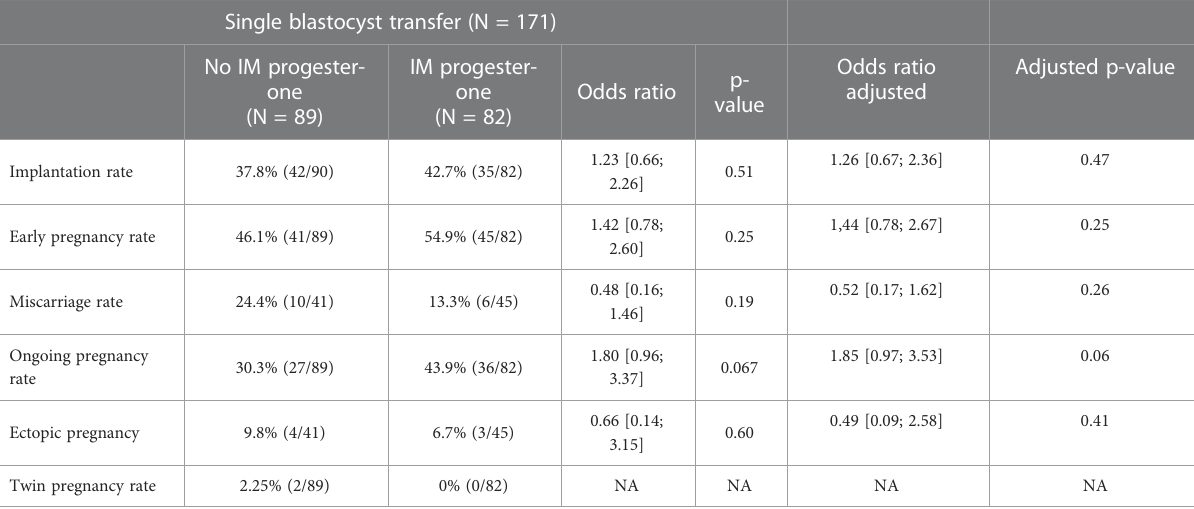
TABLE 3 IVF attempt